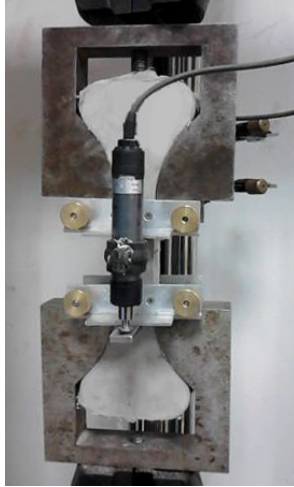
Figure 5. Test setup (tensile test system, Xinsansi, Shenzhen, China) for direct tension